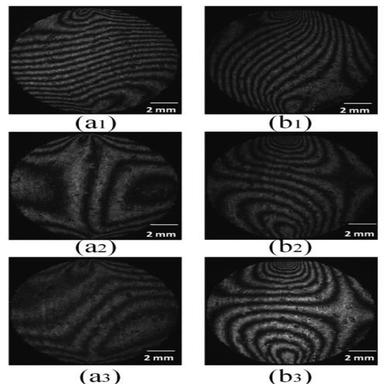
Fringe patterns with a load of 818 N along the x axis, (a1)-(a3), and y axis, (b1)-(b3), with different rigid-body rotations.